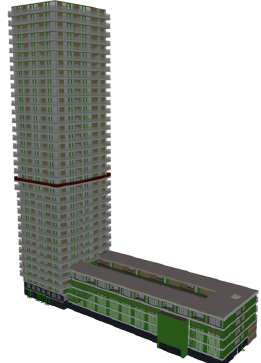
Figure 4. The architectural model of UpTown model.